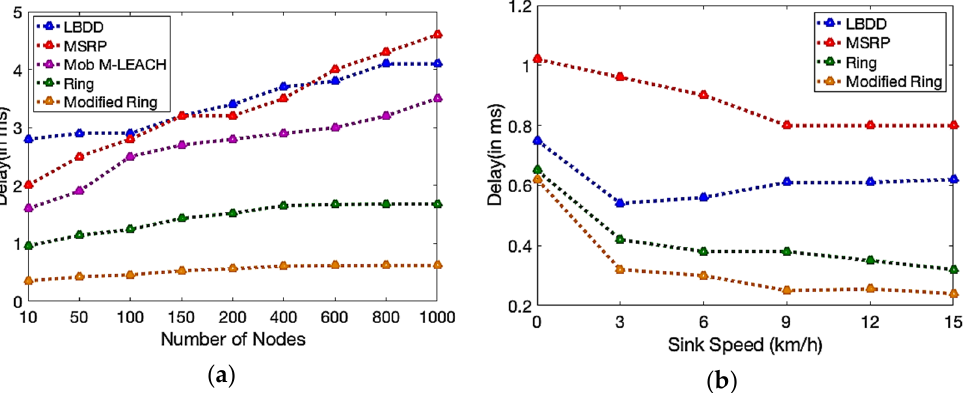
Figure 12. End-to-end delay analysis; ( a ) variation in the network density; ( b ) variation in the sink speed.